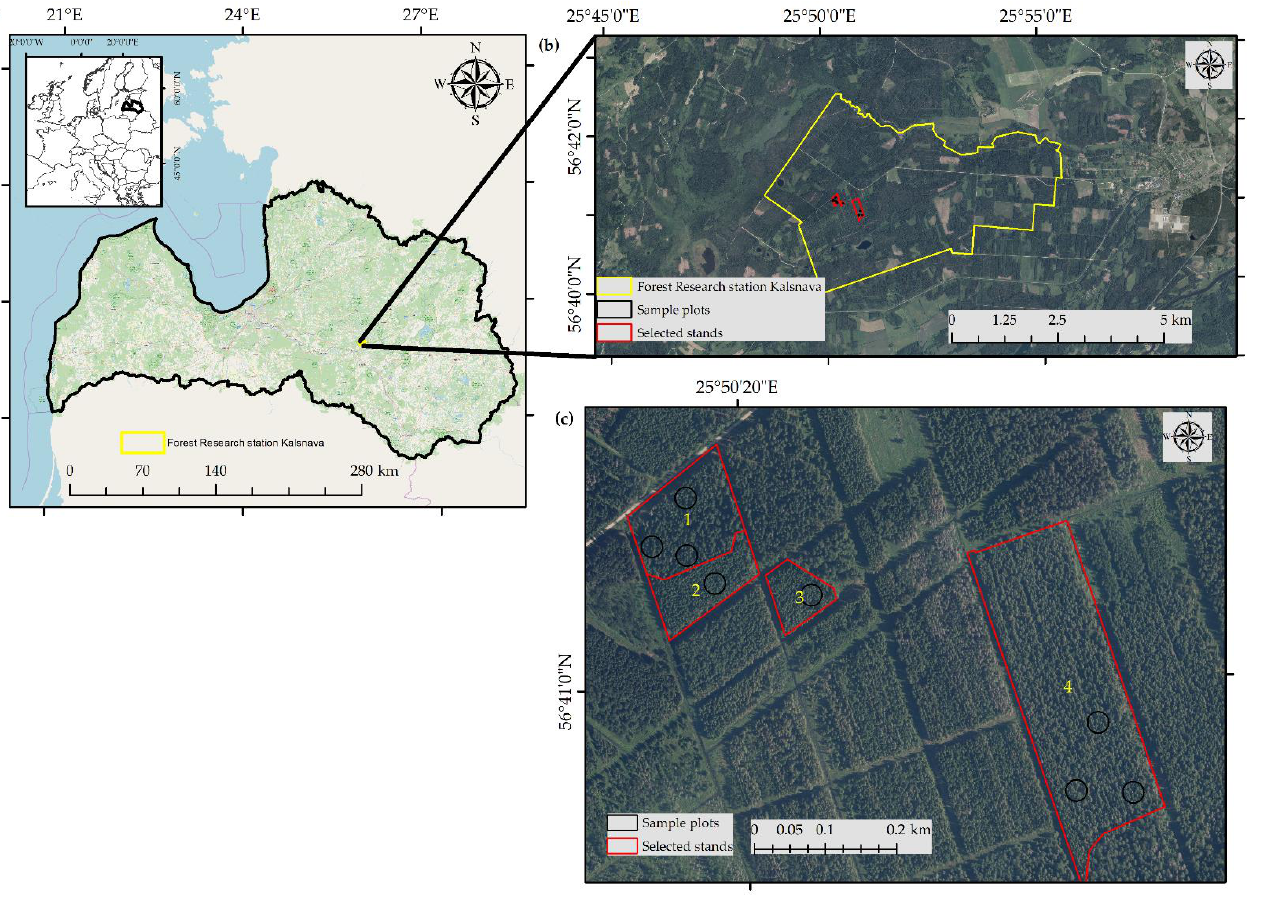
Figure 1. Location of the study sites in Latvia. ( a ) The selected sites displayed on a map of Latvia (OpenStreetMap in the background); ( b , c ) Maps of the locations of the studied Norway spruce stands in the Research forests of Kalsnava; Orthophoto of Latvia in the background [39].